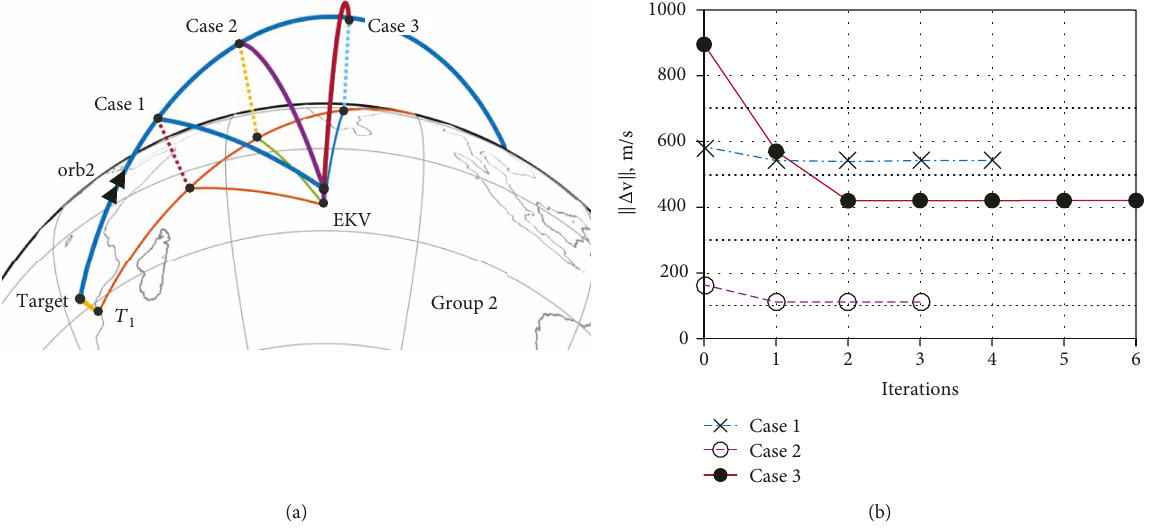
Figure 4: The engagement geometry and the iterative process of Group 2.